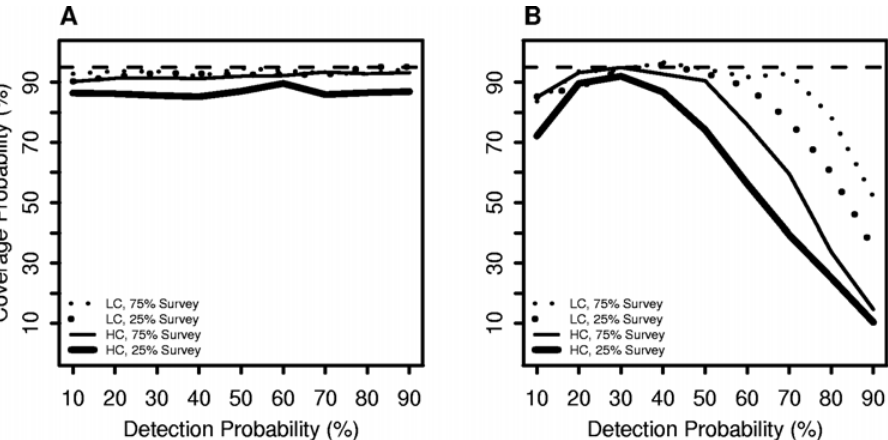
Figure 4. Changes in coverage probabilities of 95% confidence intervals for population estimates. The figures show the changes in coverage probability relative to detection probability for the low (LC) and high clustered (HC) populations at survey proportions of 25% and 75% for the double observer and double sampling methods (Panels A and B, respectively). The dashed line indicates 95% level. Coverage probability for the double sampling method remains close to the nominal level for all detection probabilities and populations but declines to less than 50% for the double observer methods at high detection probabilities.